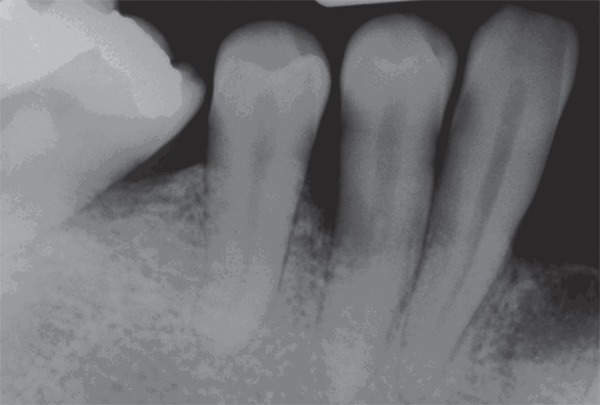
Preoperative radiograph